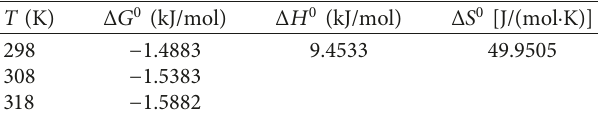
Figure 6: Effect of temperature on adsorption properties. Table 4: Thermodynamic parameters of uranium(VI) adsorption by modified rice stem.